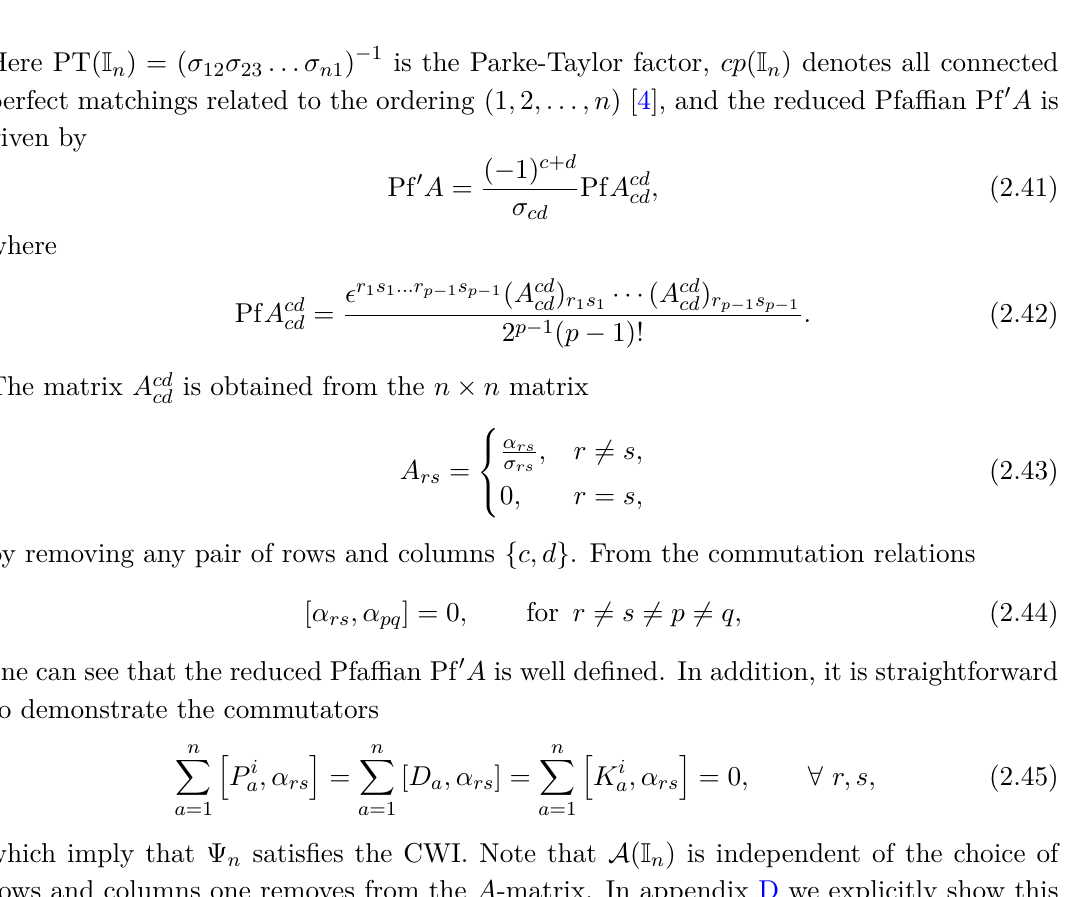
Figure 1 . Graph representation of A ( I n : 1 p − 2 , 2 p + 2 , 3 n − 1 , . . . , n p )